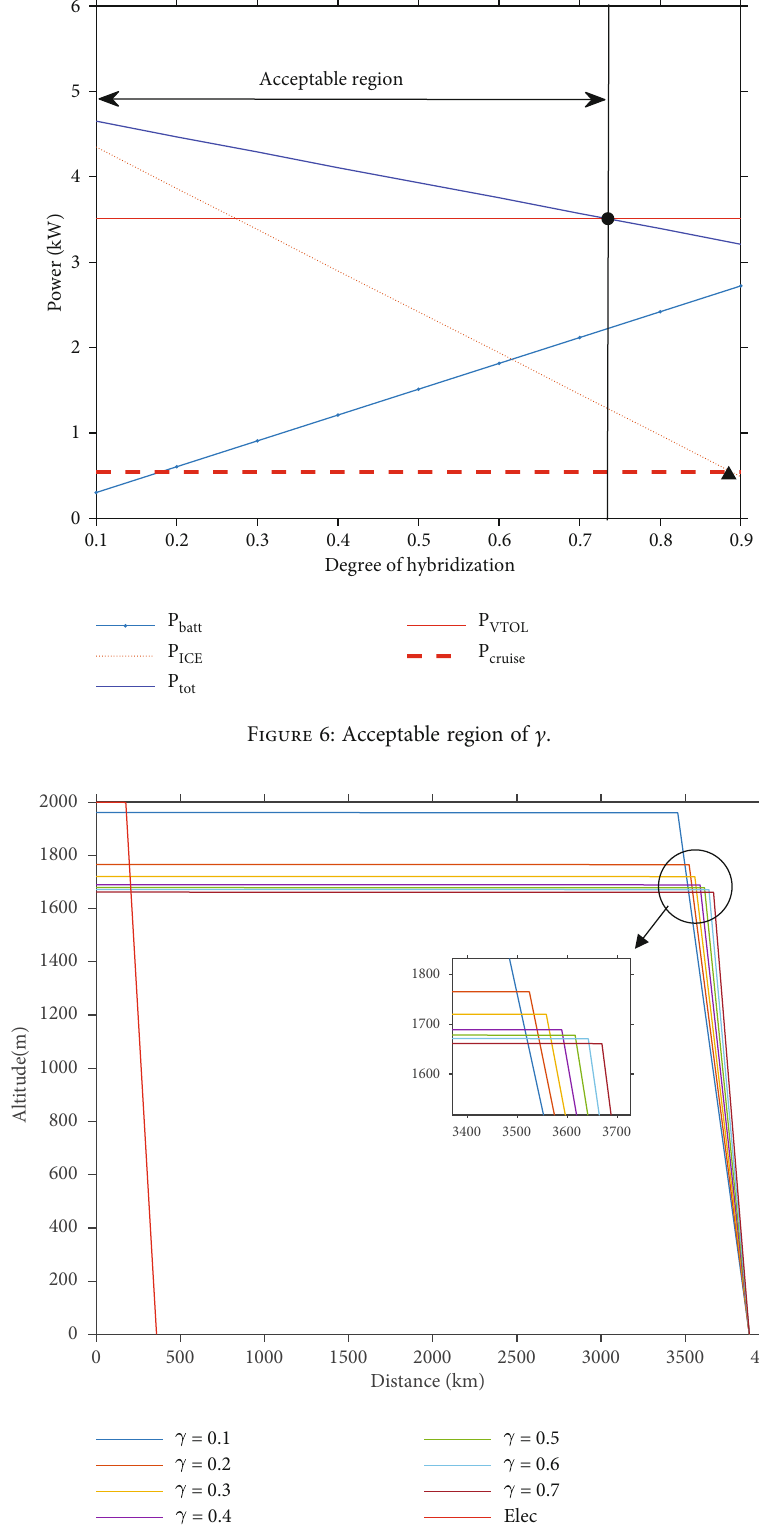
Figure 7: Di ff erent areas of the mission pro fi